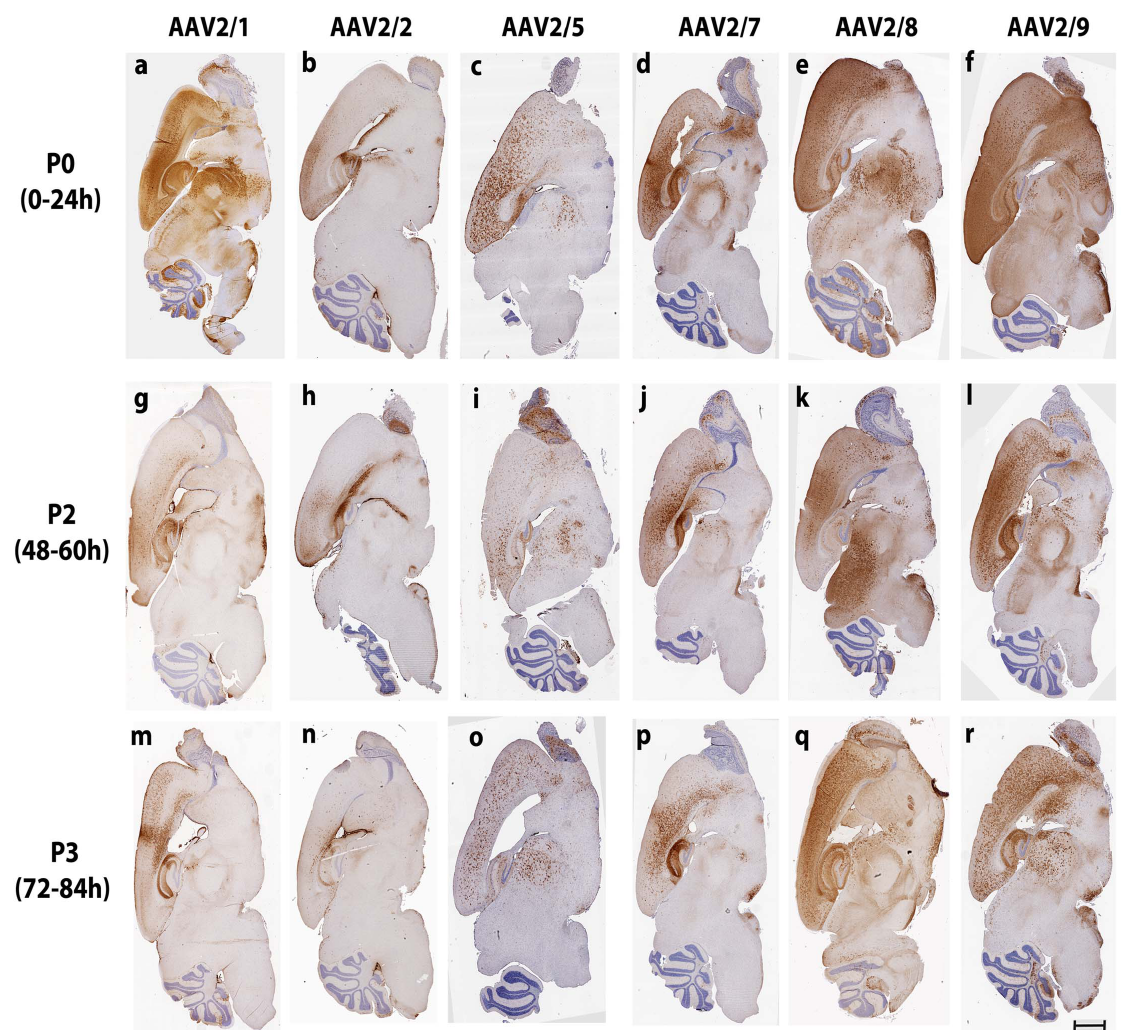
Figure 3. Immunohistochemical analysis of EGFP biodistribution following intracerebrovcentricular AAV delivery in neonatal mice. Representative sections of 3 week old mice injected on neonatal day P0, P2 or P3 show that the biodistribution of EGFP is dependent on serotype used and the time of injection. a,g,m, AAV2/1; b,h,n, AAV2/2; c,i,o, AAV2/5; d, j, p, AAV2/7; e, k, q, AAV2/8; f, l, r, AAV2/9; a-f, P0 injection, g-l, P2 injection, m-r, P3